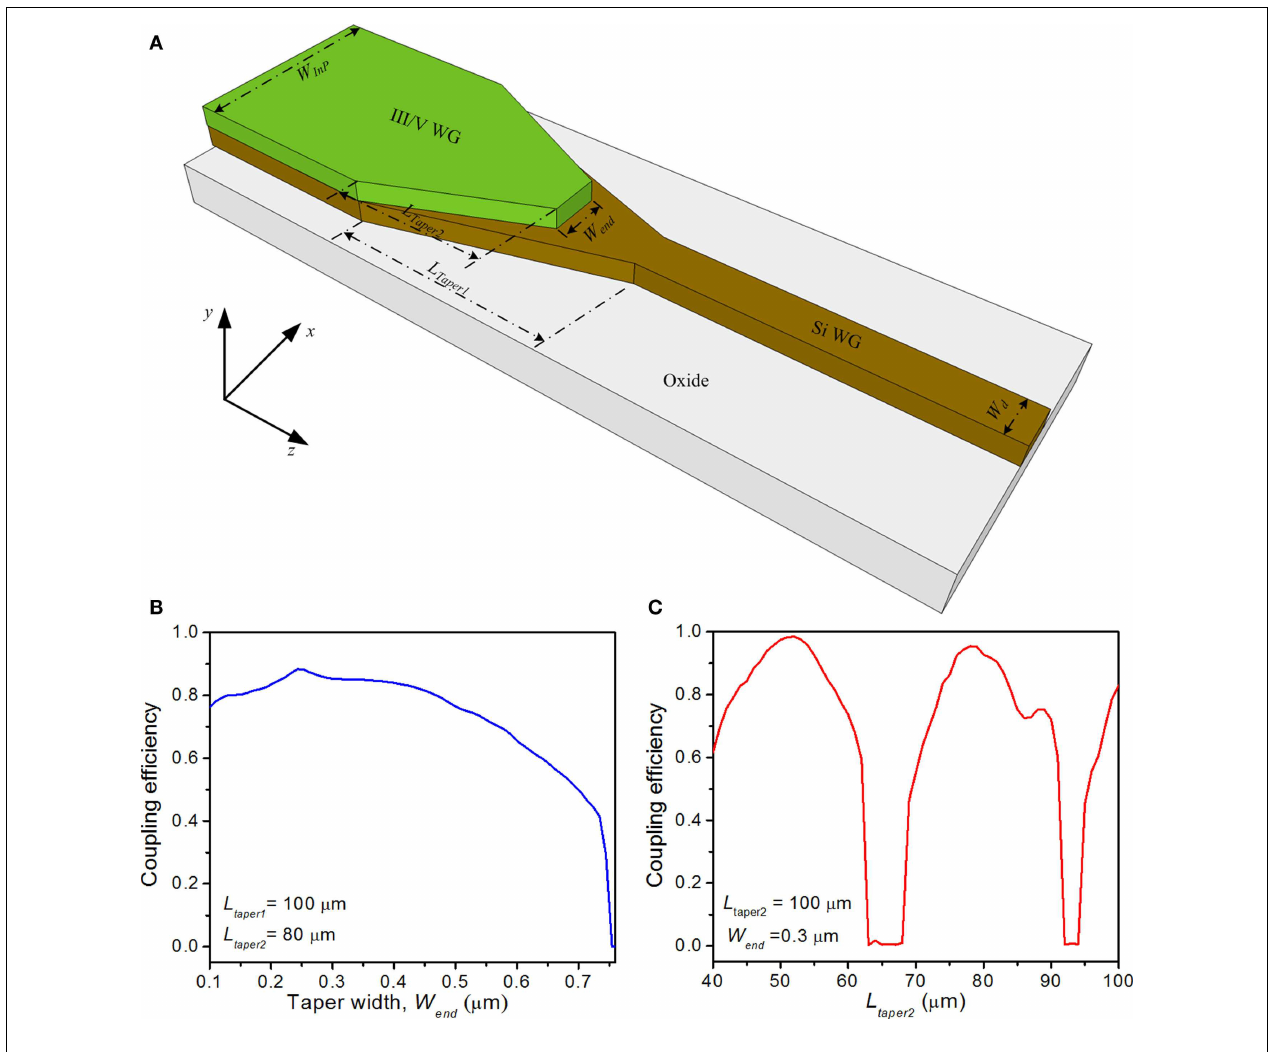
waveguide taper length.The whole structure is cladded with oxide. Coupling efficiency of III/V waveguide to Si waveguide as functions of (B) the III/V waveguide taper width, and (C) the III/V